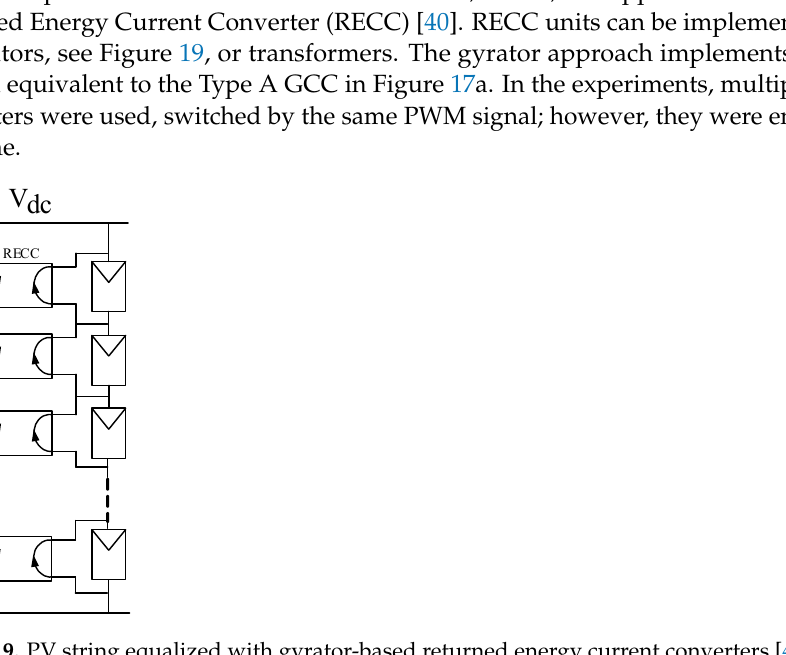
Figure 18. PV string with shuffling equalization scheme.